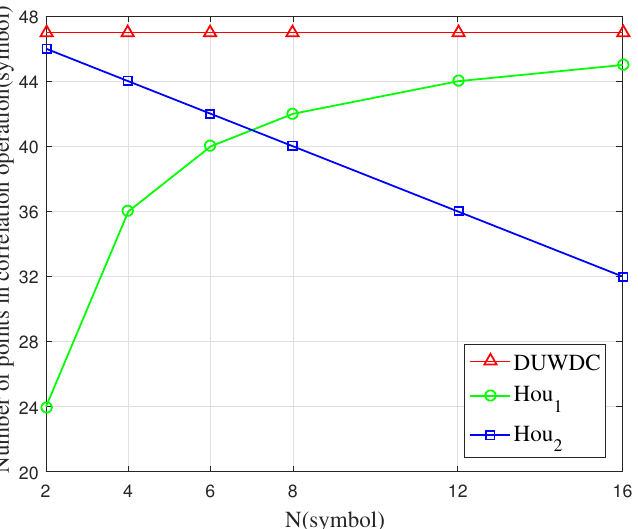
Figure 8. The relationship between the number of correlation operation points and UW distribution